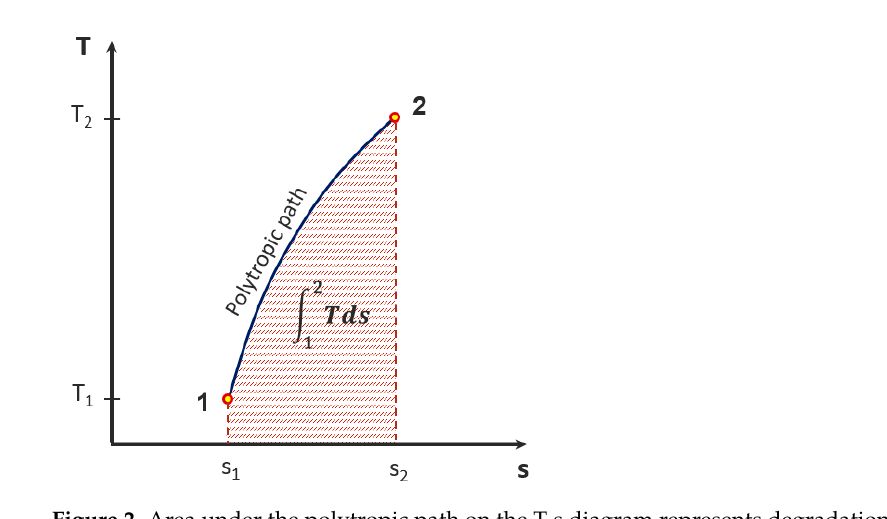
Figure 2. Area under the polytropic path on the T-s diagram represents degradation of energy in a polytropic compression process. Additionally, see Figure 10 for different possible curve shapes of the polytropic path between endpoints.